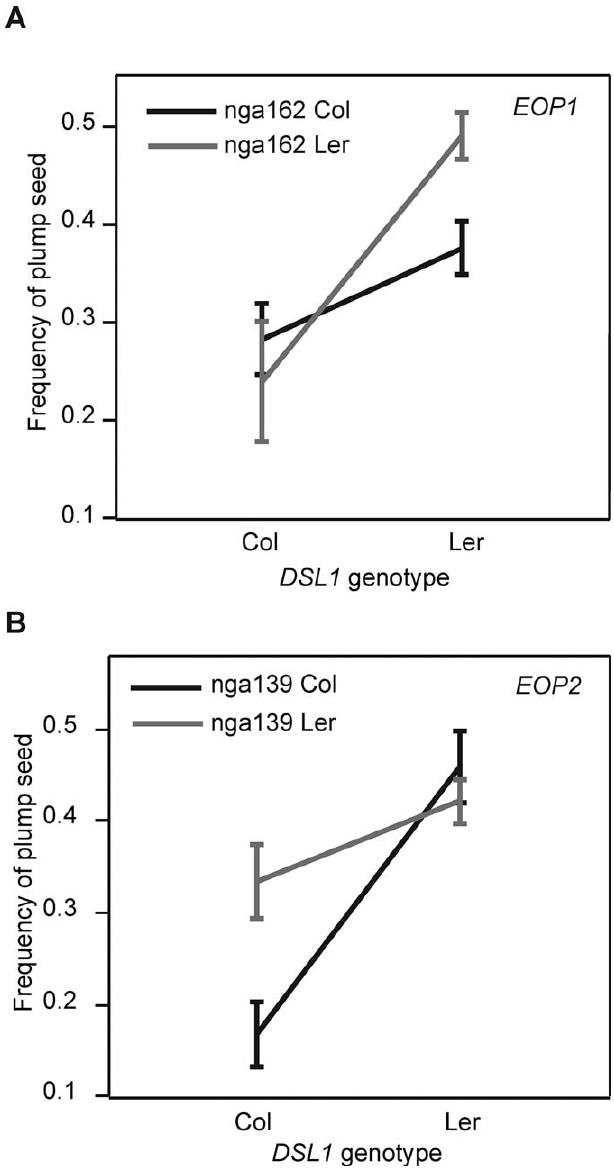
Figure 4. DSL1 Interacts with at Least Two Loci to Control the Interploidy Hybridization Barrier The genotype at marker g17288, which had the highest likelihood ratio in the RIL population, was used for the DSL1 genotype on the x -axis. The y -axis corresponds to the mean frequency of plump seed for each genotype. Error bars indicate the standard deviation from the mean. The grey and black lines correspond to the Ler and Col alleles of nga162 at the position of EOP1 on chromosome 3 (A) and nga139 at the position of EOP2 on chromosome 5 (B).